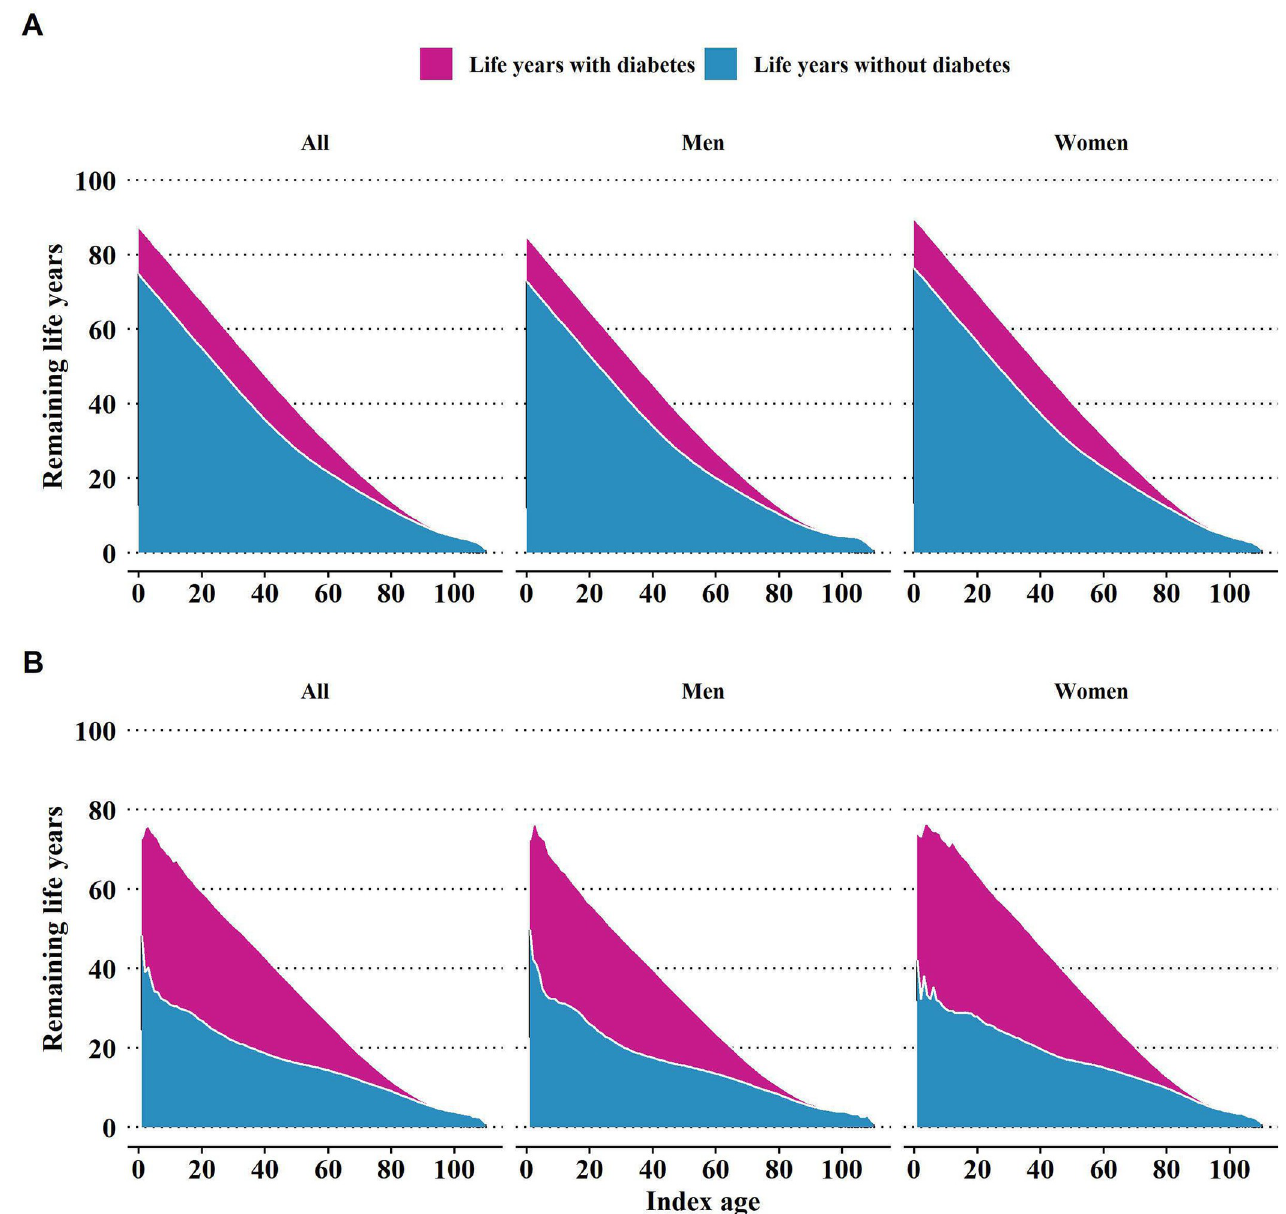
Fig 2. Expected remaining life years with and without diabetes after index age in men and women according to glycemia status. (A) People with normoglycemia. (B) People with